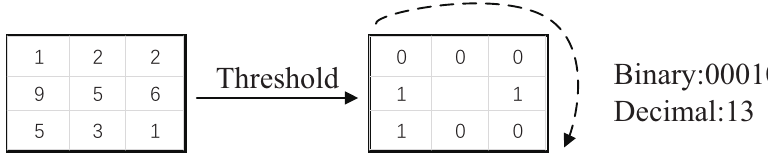
Figure 2. The flow of the LBP algorithm. The value greater than the center point is assigned as 1, and the value less than the center point is assigned as 0. Read clockwise to obtain binary coded